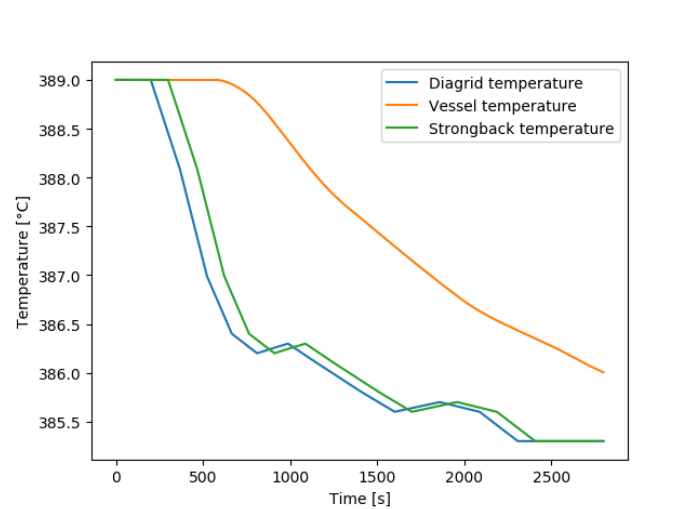
Figure 3: Temperature of Diagrid (Inlet), Strongback and Vessel during the MOCF1